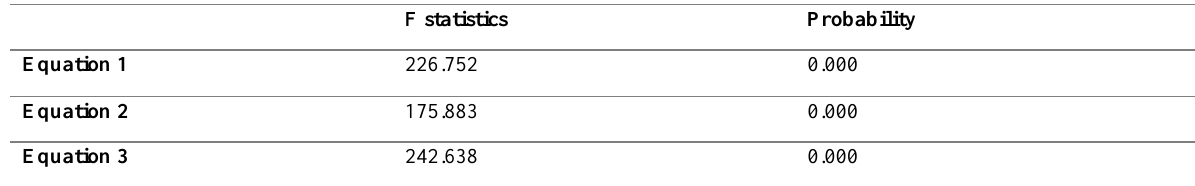
Table 5 : Simultaneous Significance